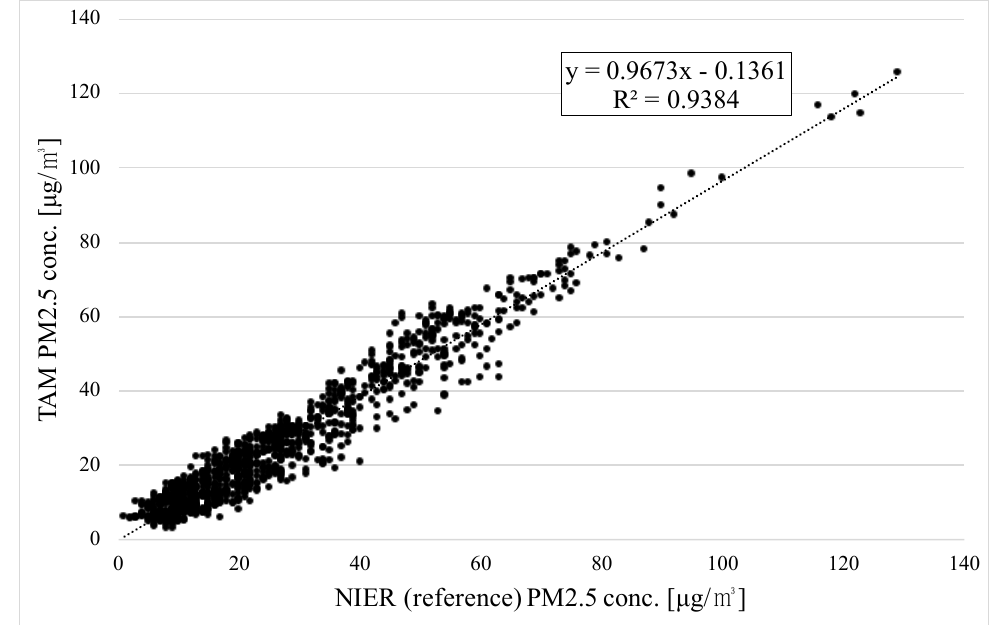
Figure 12. Correlation between TAM and NIER on hourly average from 26 January to 9 March 2021.